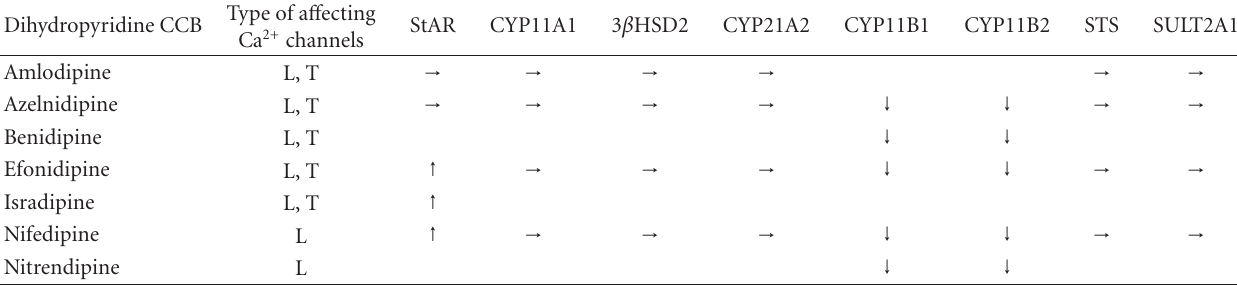
Table 1: The e ff ects of dihydropyridine CCBs on dbcAMP- or KCl-induced expression of steroidogenic enzymes. Type of a ff ecting Dihydropyridine CCB StAR Ca 2+ channels